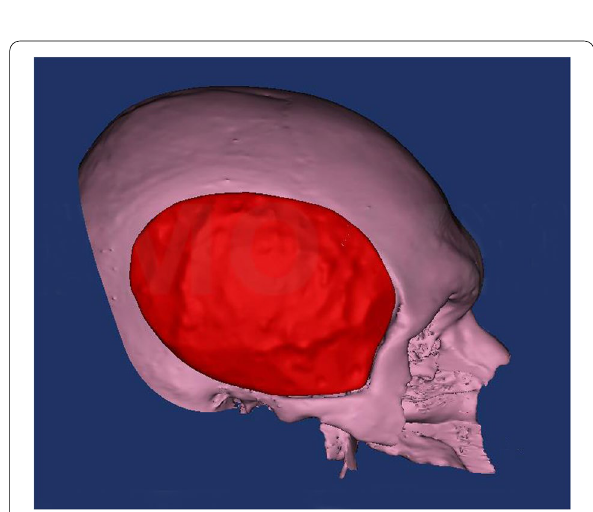
Fig. 2 The muscle refined to create the final virtual temporal implant (red)